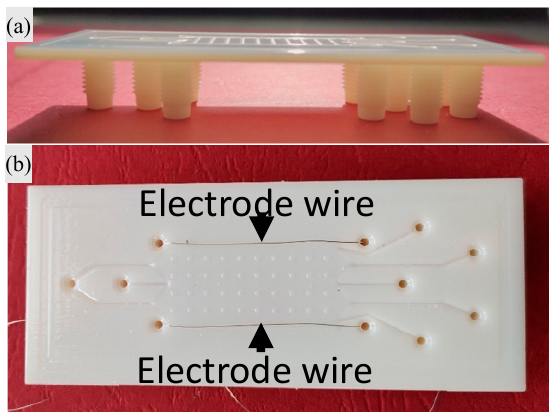
Figure 2. Micro free-flow electrophoresis (µFFE) device fabrication: ( a ) 3D printed microfluidics and ( b ) electrode insertion in the final device.